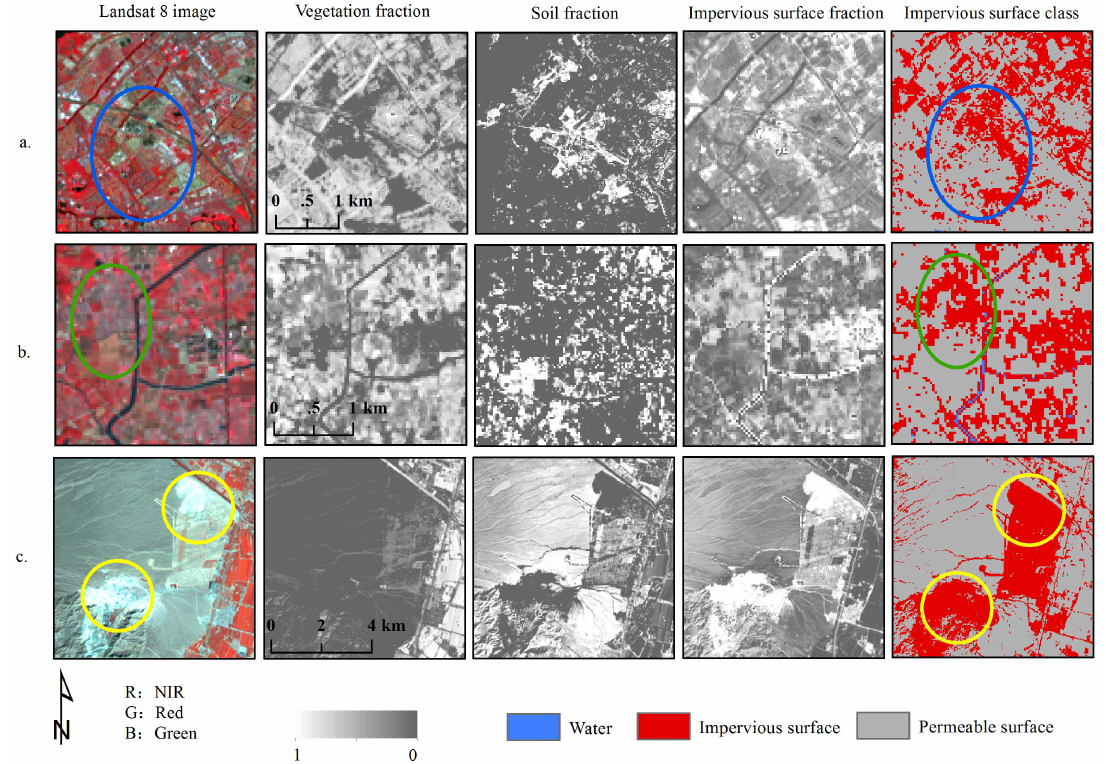
Figure 9. Examples of impervious surfaces that are misclassified. Landsat 8 images are displayed under the band combination of R = NIR, G = red, and B = green. In grayscale images, the brighter the color, the higher the percentage of the impervious surface fraction, vegetation fraction, and soil fraction. In class maps, the impervious surface class is red, the permeable class is gray, and water is blue. ( a ) In Kunming (28 May 2015), most of the mixed pixels (blue oval) between vegetation and impervious surface were not classified as impervious surfaces; ( b ) in Ningbo (23 March 2015), bare land (green oval) was misclassified; and ( c ) in Yinchuan (1 September 2015), bare sand soil (yellow circles) was